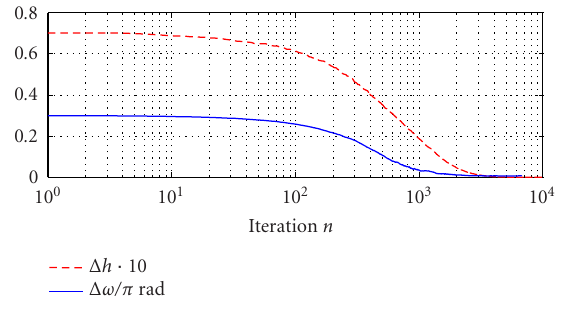
Figure 11: Learning curves for carrier frequency (COC), ω , and modulation index (MIOC), h , o ff set correction µ initial Θ = 0 . 002 and µ h = 0 . 001.